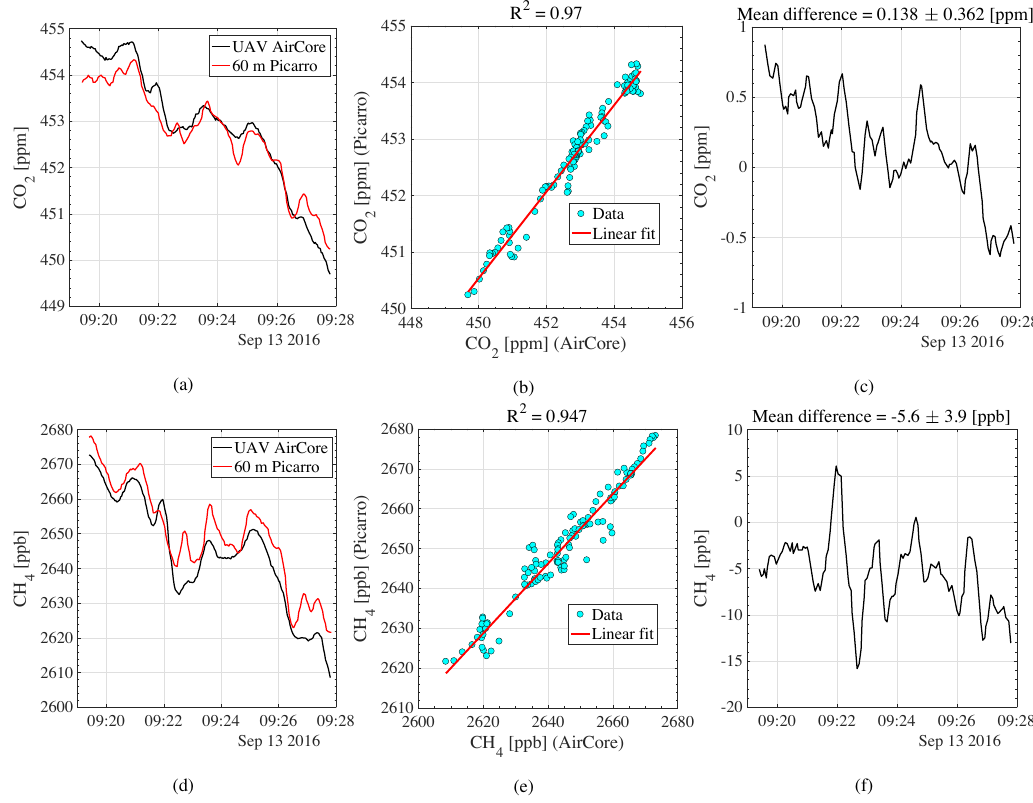
Figure 11. The AirCore analysis of the fifth flight and the continuous tower measurements from 60m. The plot shows the analysis profiles and the correlation between these two measurements from both CO 2 and CH 4 . The differences in CO 2 and CH 4 between the two measurements are also